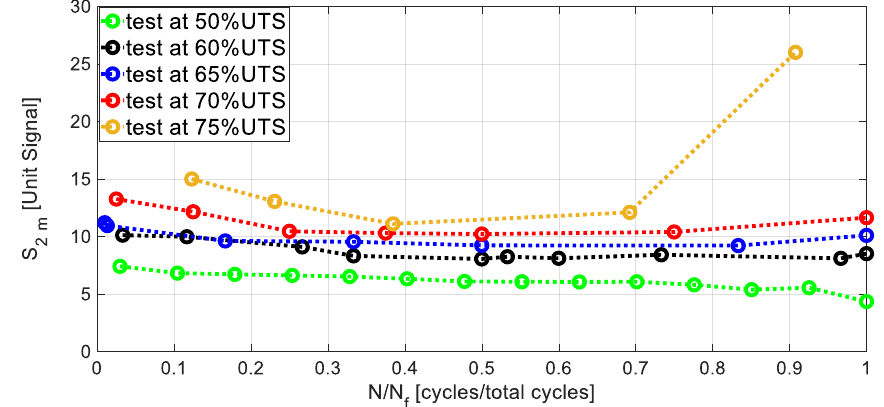
Figure 7. Evolution of the S 2 _m through N/N f for each stress level.